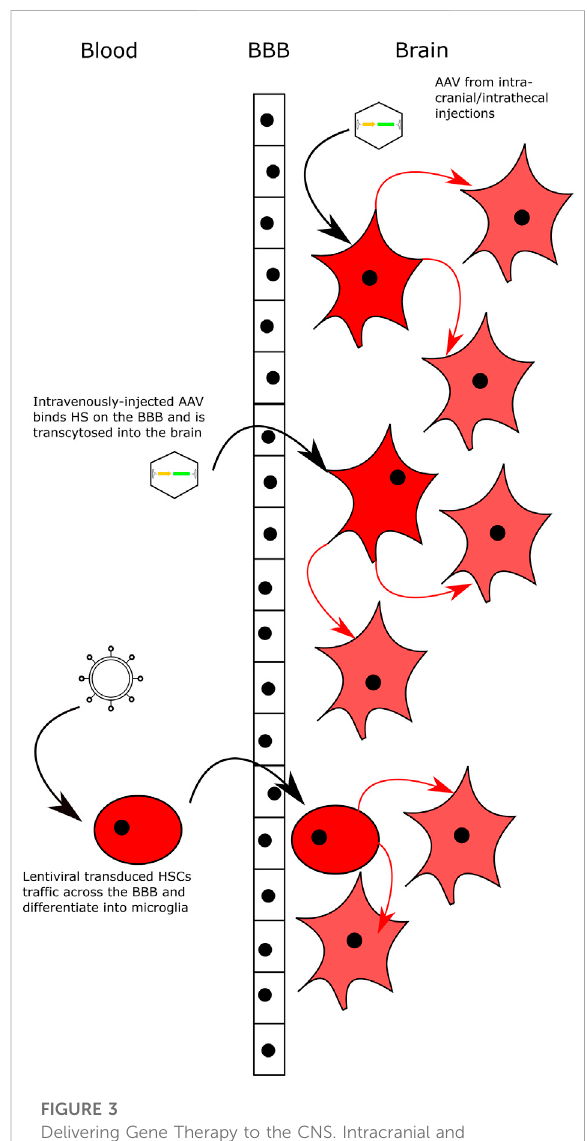
FIGURE 3 Delivering Gene Therapy to the CNS. Intracranial and intrathecal delivery of AAV vectors bypasses the BBB by direct injection into the CNS. Intravenous delivery of AAV serotypes that can bind HS on the surface of the BBB and are transcytosed across the BBB into brain. Lentiviral-transduced HSCs can cross the BBB and engraft in the brain following transplantation with myeloablative conditioning. All delivery methods lead to transduced neuronal cells that secrete high levels of the relevant enzyme and cross-correct neighbouring